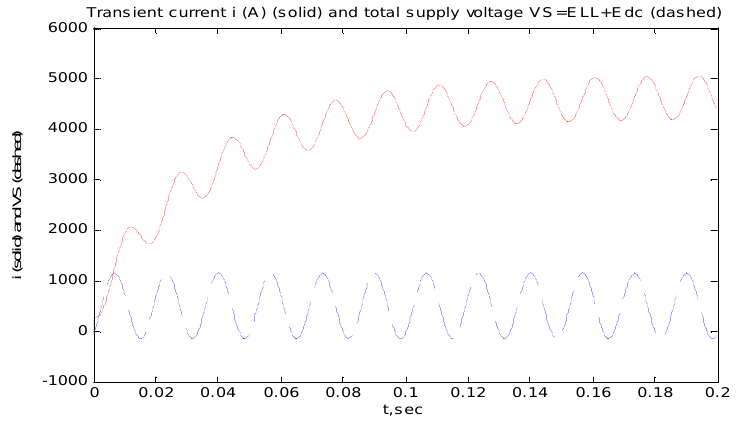
Figure 3. The internal commutation fault current and the total supply voltage EtE ++ )sin(2 θω when no fuse was used to clear the circuit. dcLL